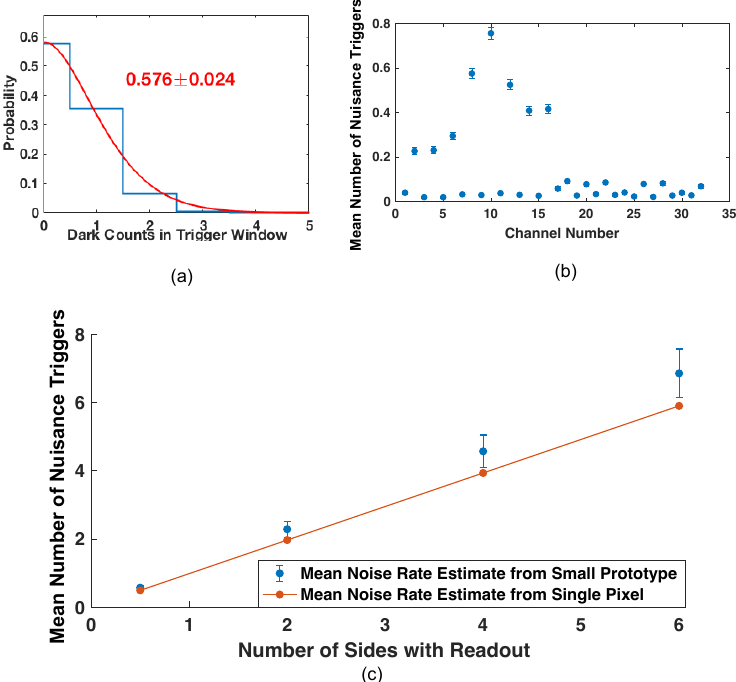
Figure 8. Example distribution of the number of “nuisance” or noise photons recorded for a channel of the small scale prototype detector is shown with a Poisson fit in ( a ). Mean number of nuisance photon triggers is plotted for each channel in ( b ). Estimated number of noise photons in a 15 ns region of time is shown as a function of the number of sides of a 5 × 5 × 5 cm 3 monolithic scintillator block instrumented with detector readout us shown in ( c